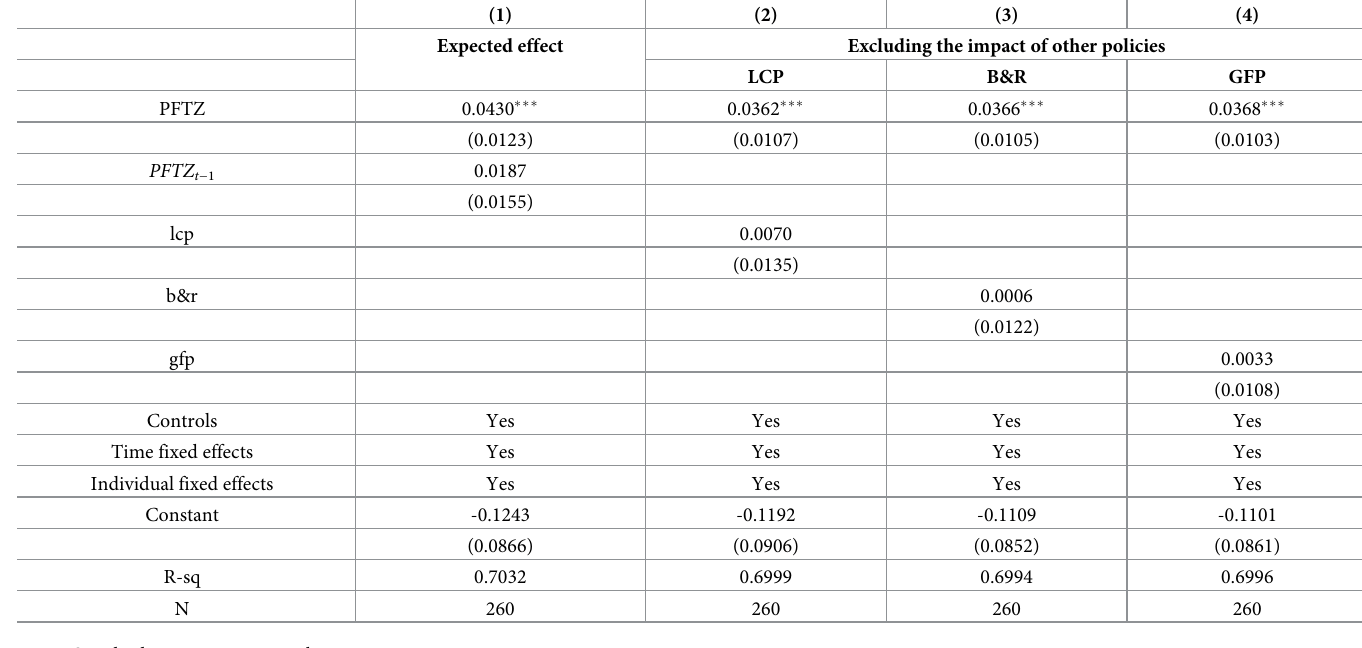
Table 7. Robustness tests.